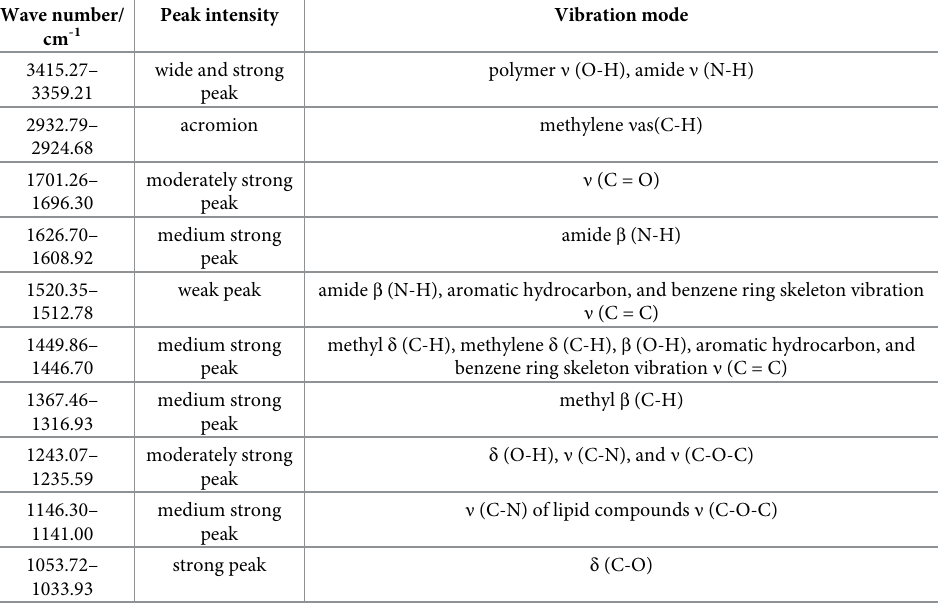
Table 4. Vibrational modes of functional groups in common peaks (distinctive region).